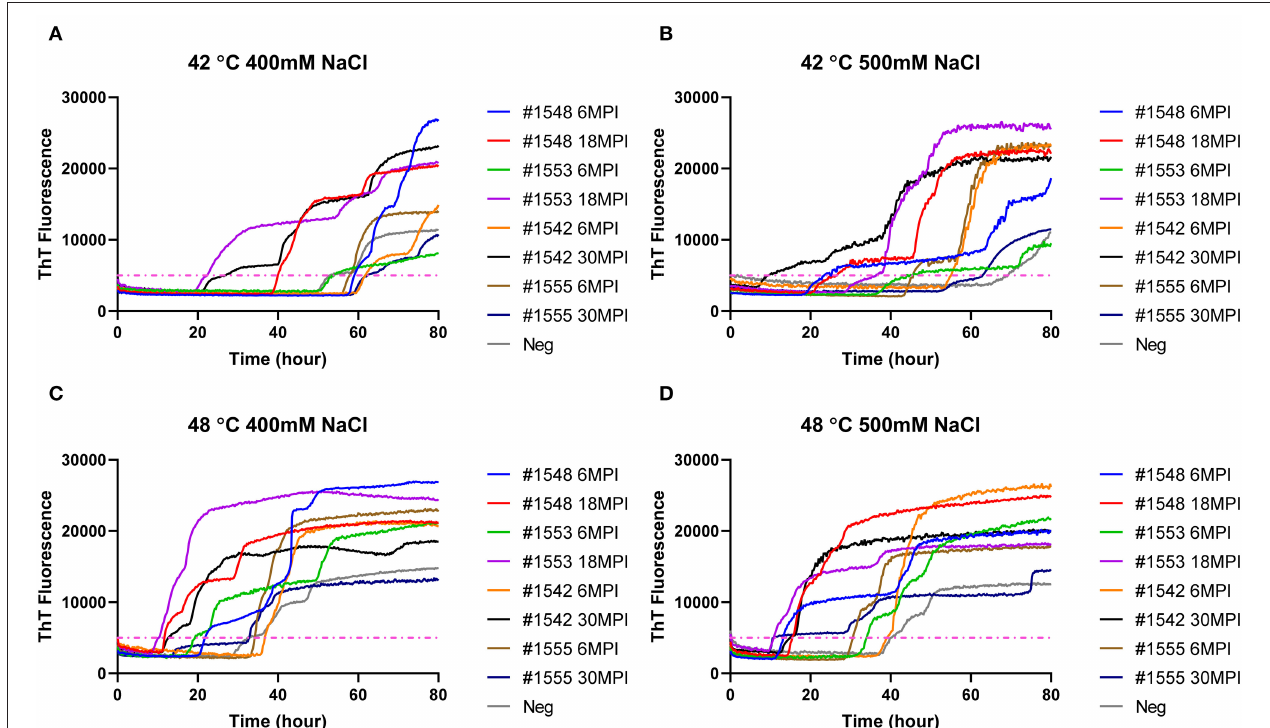
FIGURE 6 | RT-QuIC reactions seeded with biopsy fecal homogenates from preclinical white- tailed deer. Reactions conditions for each sample are followed as (A) 400mM NaCl at 42 ◦ C, (B) 500mM at 42 ◦ C, (C) 400mM at 48 ◦ C, and (D) 500mM at 48 ◦ C. Shown are the average ThT fluorescence readings determined from all replicates (four replicate reactions per each